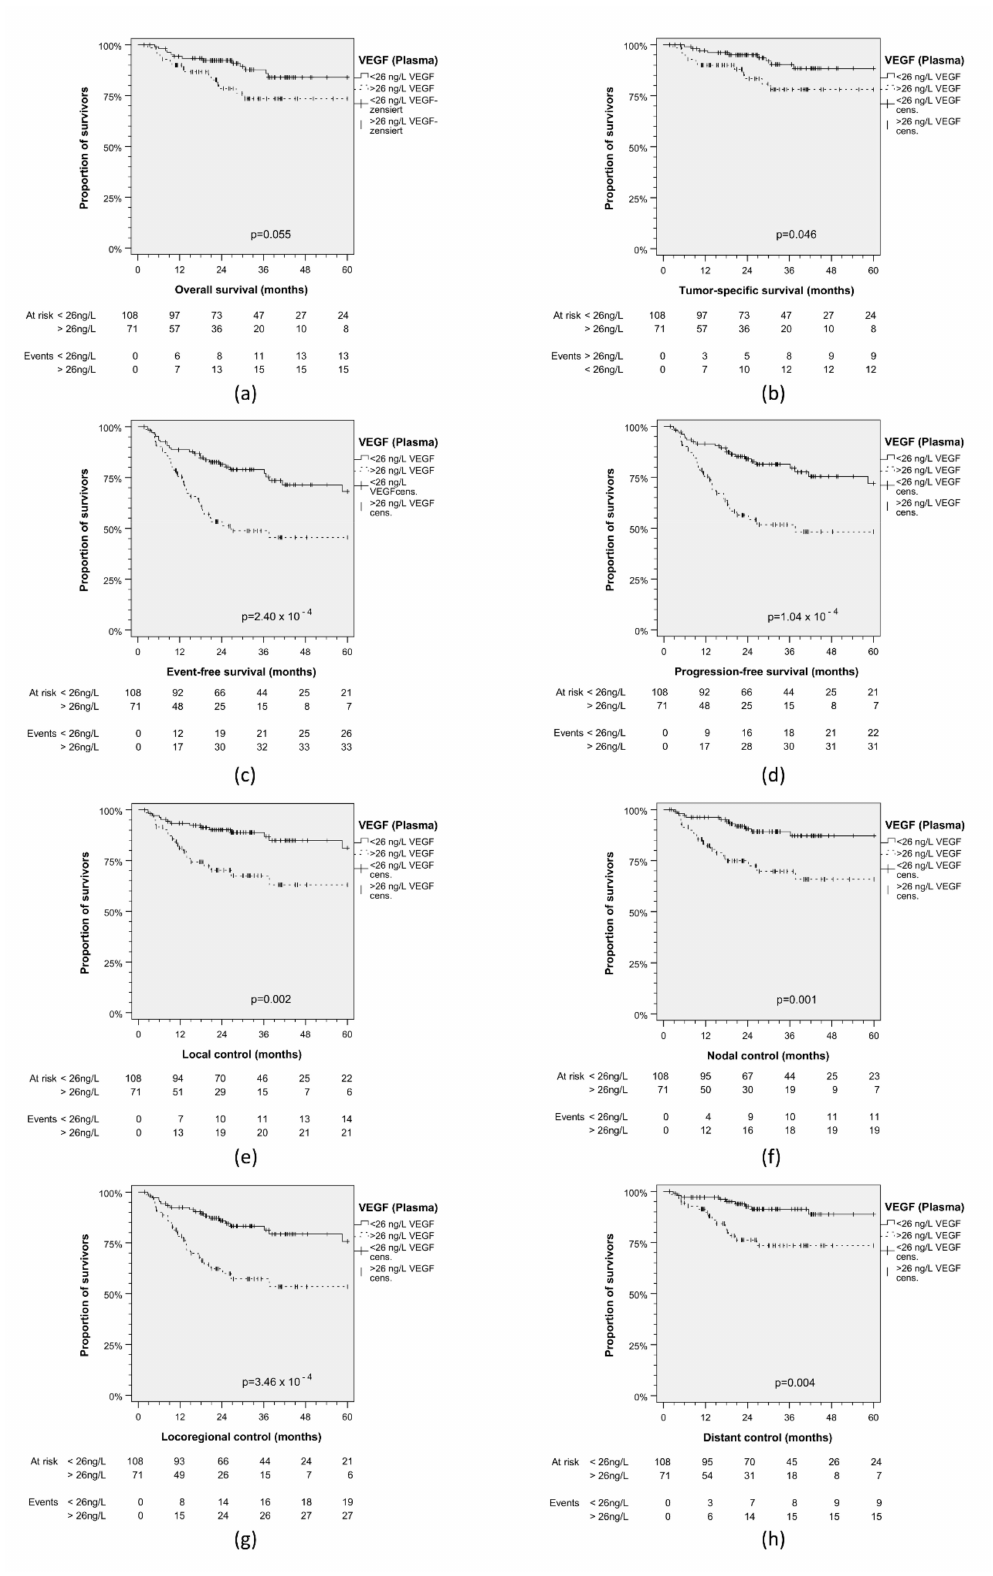
Figure 4. Kaplan–Meier plots for cumulative survival in HNSCC patients from combined test cohort and independent validation cohort stratified according to VEGF in pre-therapeutic plasma. ( a ) Overall survival; ( b ) tumor-specific survival; ( c ) event-free survival; ( d ) progression-free survival; ( e ) local control; ( f ) nodal control; ( g ) loco-regional control; ( h ) distant control. p values shown are from 2-sided log-rank